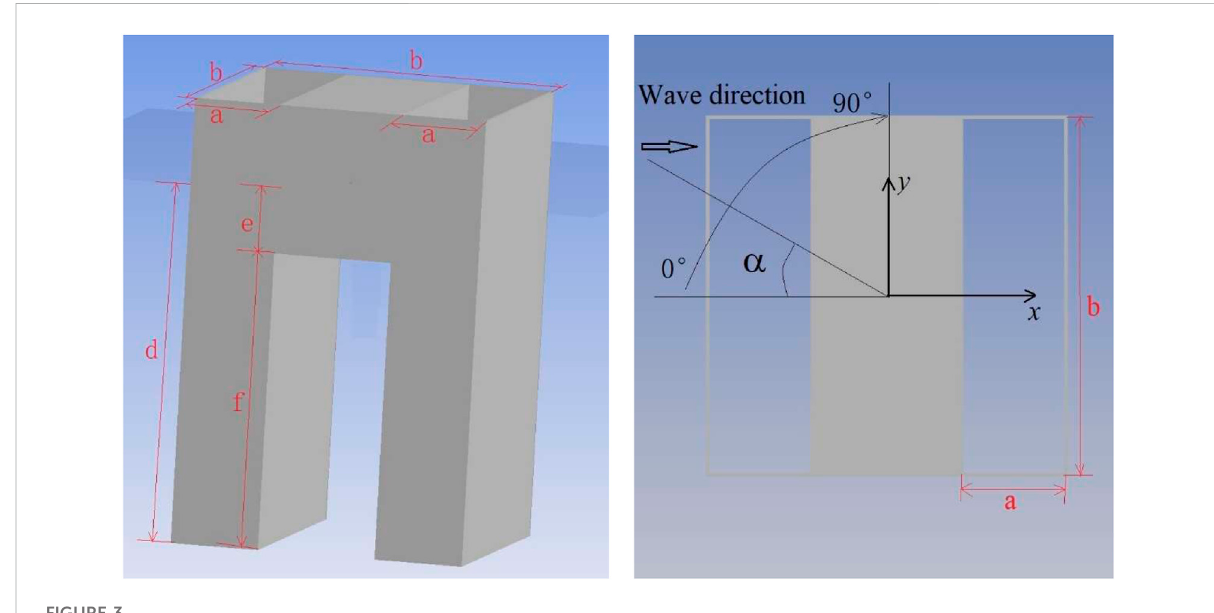
FIGURE 3 Dimensional parameters of the dual-chamber OWC WEC model.